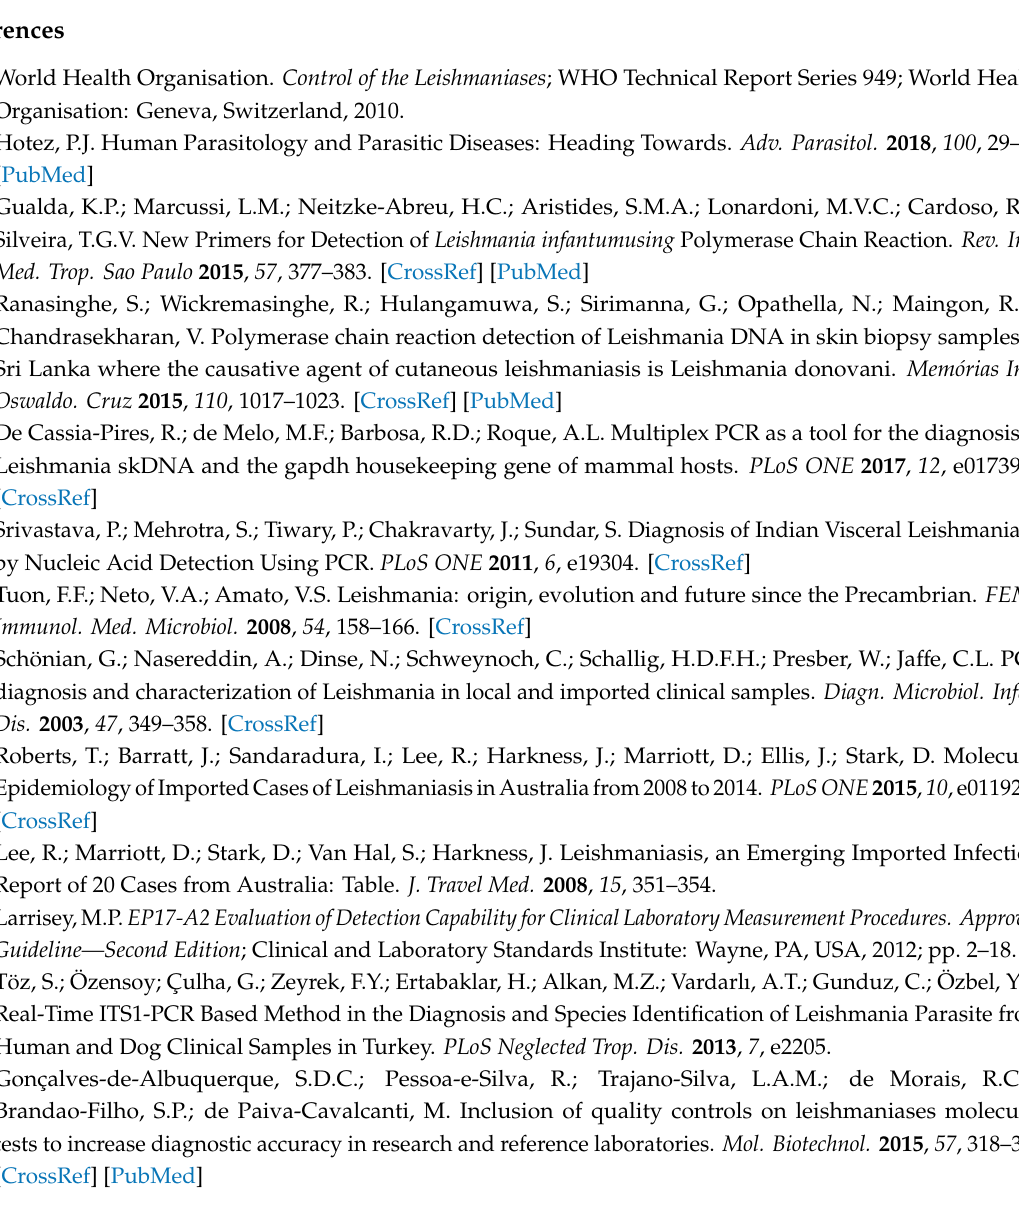
Figure S1: Conventional and bisulphite converted alignments for the 18S rDNA gene, Table S1: Conventional and bisulphite converted primer and probe designs for the novel